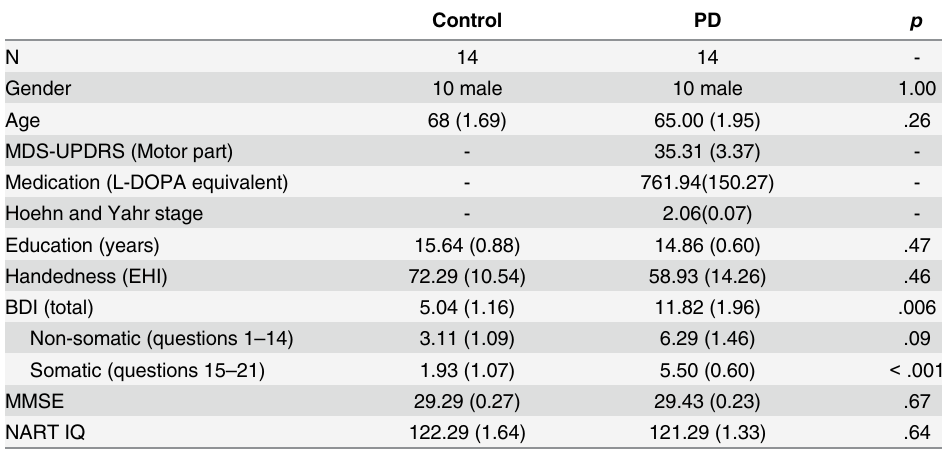
Table 1. Demographic data and scores on tests of cognition, executive function and mood scales for controls and patients with Parkinson ’ s disease (PD). The data are means ( ± SEM).